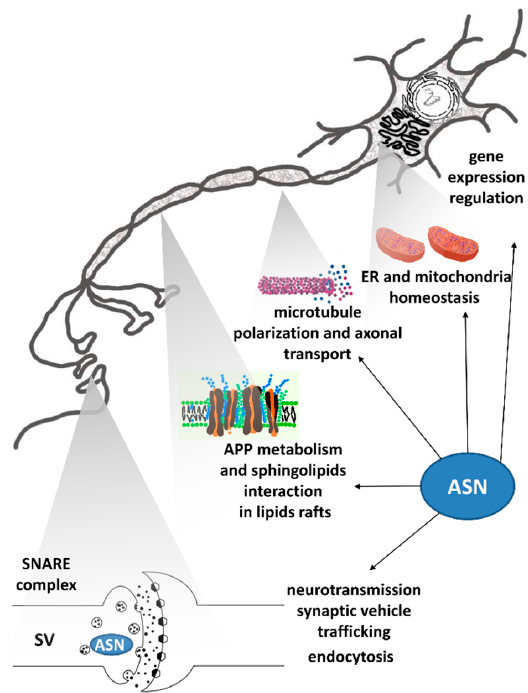
Figure 1. ASN function within different cellular compartments. Abbreviations: ASN—alpha-synuclein; APP—amyloid-beta precursor protein; ER—endoplasmic reticulum; SV—synaptic vesicles; SNARE complex–soluble N-ethylmaleimide-sensitive factor attachment protein receptor complex.